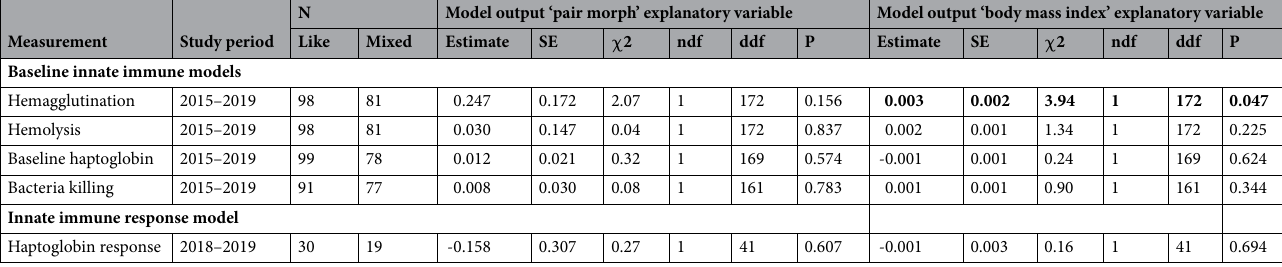
Table 1. Model outputs of linear mixed models for the key explanatory variables of the ‘baseline innate immune models’ (response variables: hemagglutination, hemolysis, bacteria-killing capacity and baseline haptoglobin) and ‘innate immune response model’ (response variable: haptoglobin response, quantified as the difference between baseline haptoglobin concentration and haptoglobin concentration post-injection of lipopolysaccharides). Key explanatory variables are parental ‘pair morph’ (factor in two levels: ‘like-morph’: dark-dark D ♂ D ♀ and light-light L ♂ L ♀ ; or ‘mixed-morph’: dark–light D ♂ L ♀ and light–dark L ♂ D ♀ ,